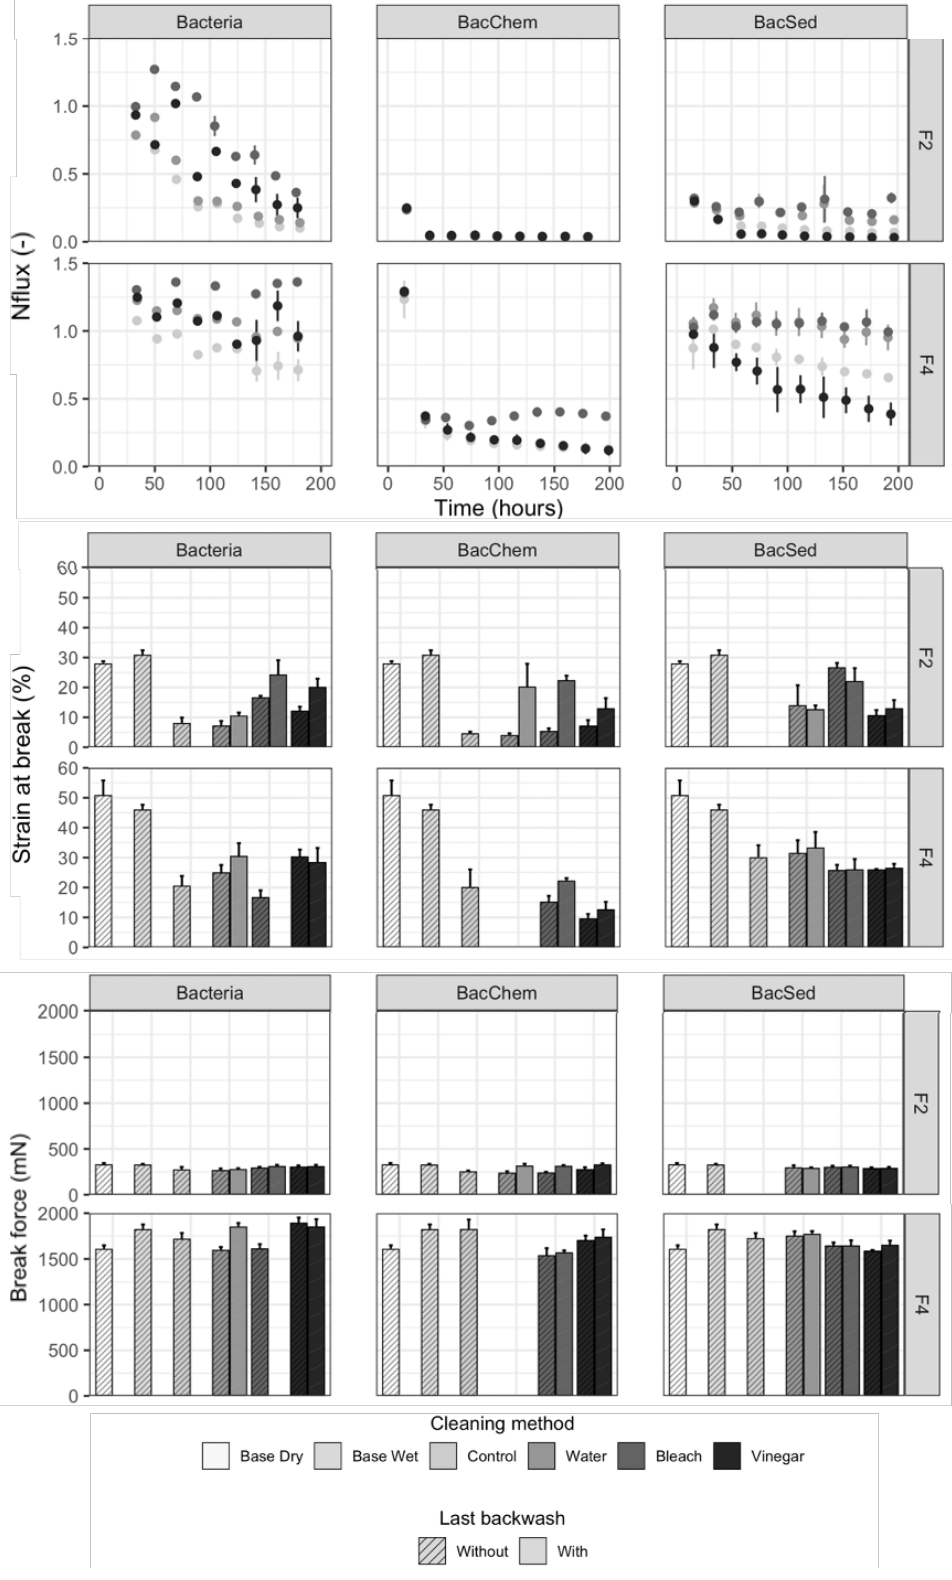
Figure 3. Normalized flow, strain at break, and break force for MF membranes (F2) and UF mem- branes (F4) by influent water (Bacteria, BacChem, and BacSed), backwashing solutions (colors: controls, water, bleach, and vinegar), and backwashing completion (shade-in, without and with a last backwash). Results for F1 and F3 are similar and presented in the supporting